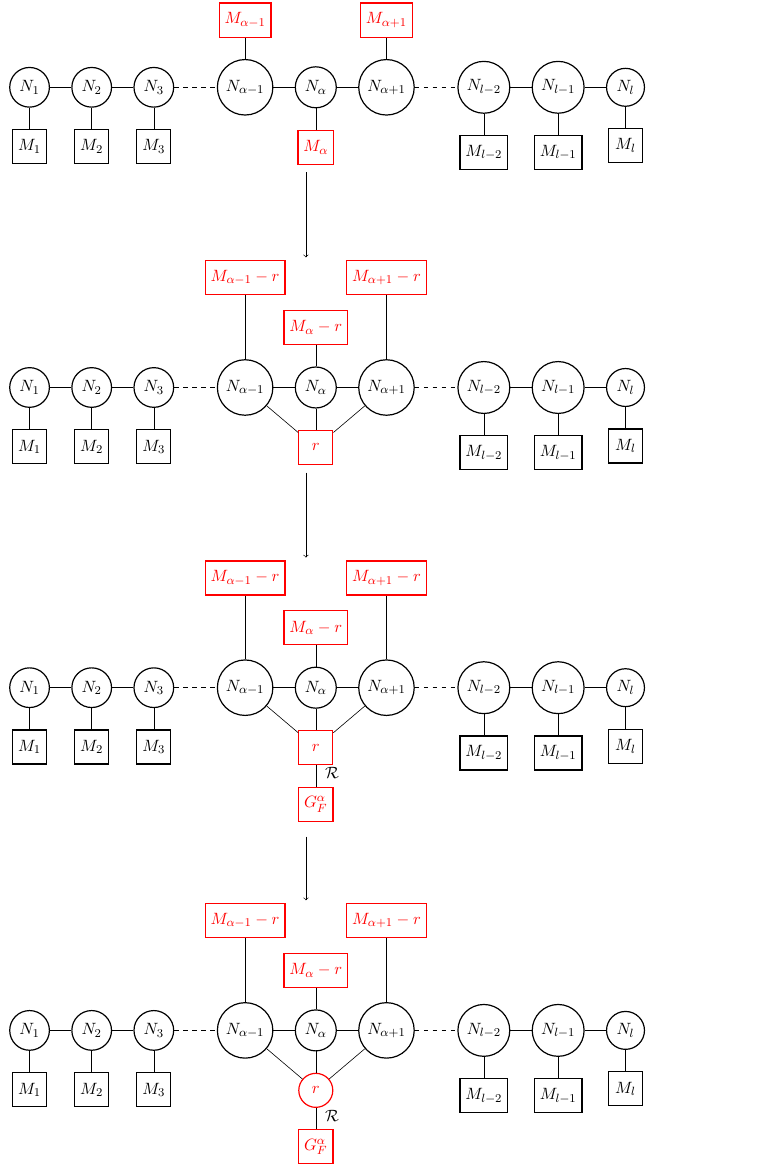
operation on a generic ◦ F α ◦ I α P P P